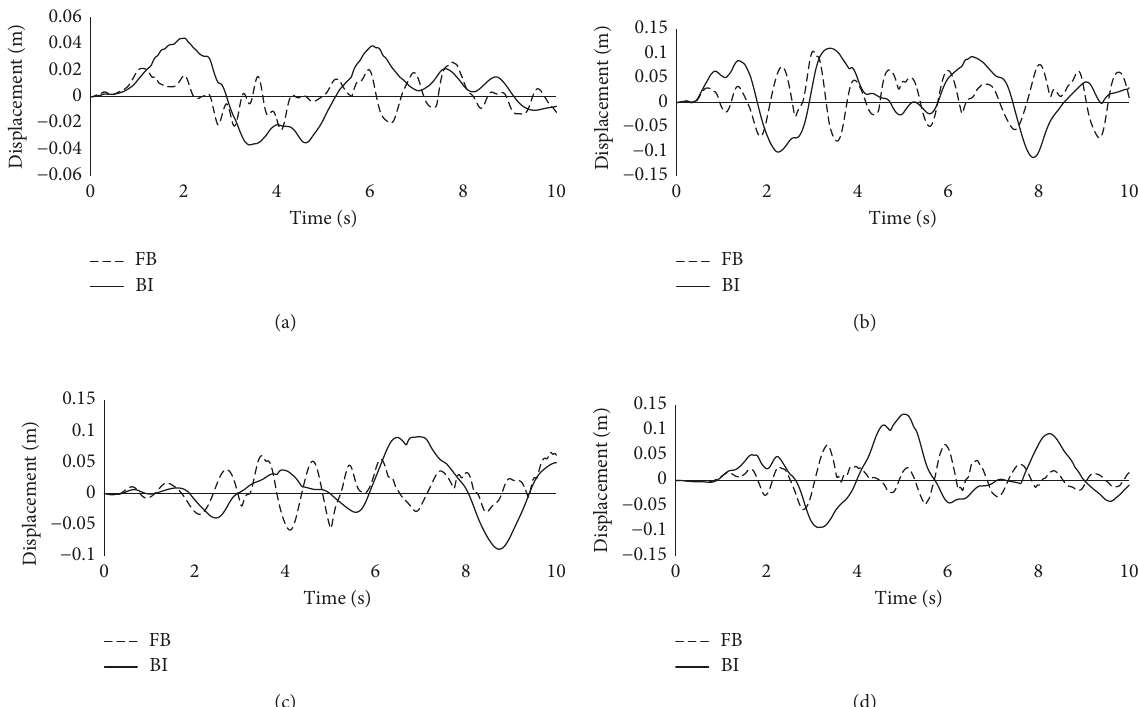
Figure 10: Displacement time history response of the shorter building at the pounding level under the motions. (a) Cape. (b) LACC-N. (c) S-Monica. (d)